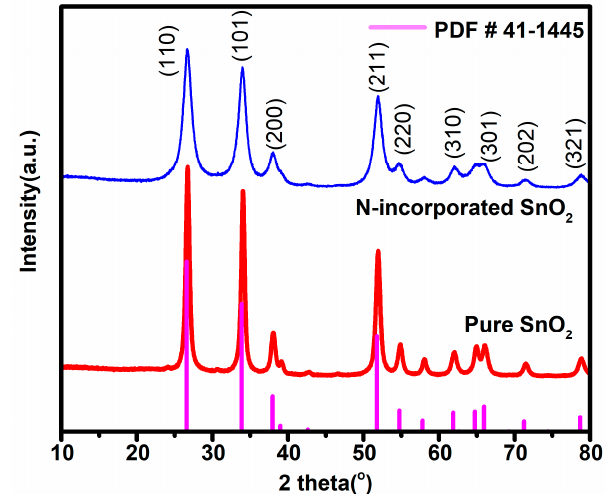
Figure 3. The XRD patterns of N-incorporated SnO 2 and pure SnO 2 samples.